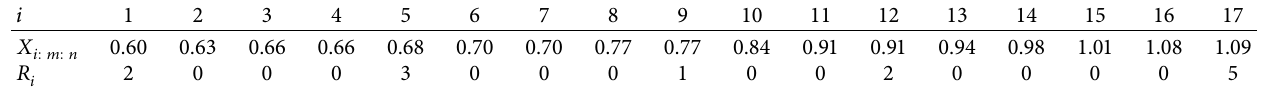
Table 2: Progressive Type-II censored tumor-free time data and corresponding censoring scheme.